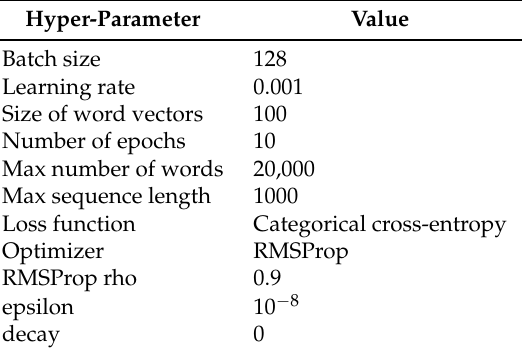
Table 5. CNN classifier